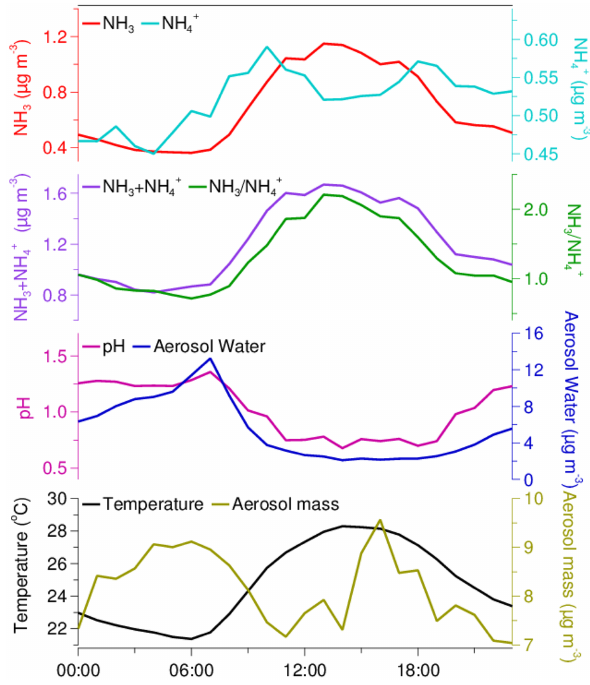
Figure 8. Amines, NH 3 and CH 3 CN concentrations measured on 4 June 2014 in the Alabama forest. The measured ambient temper- Figure 7. The average diurnal variation of the gas phase NH 3 (red), ature is also shown. There was a local trash burning event starting aerosol-phase ammonium (NH + , cyan) measured with ion chro- 4 around 10a.m. The blank period of amines and NH 3 in the after- matography (IC), the sum of NH 3 and NH + (purple), the ratio noon was due to a power outage in the trailer where the CIMS was 4 of NH 3 to NH + (green), ISORROPIA-predicted aerosol pH (ma- 4 genta), ISORROPIA-predicted aerosol water content (blue), ambi- ent temperature (black), and aerosol mass (yellow) for the entire SOAS campaign period. The unit of gas-phase NH 3 concentrations was converted from ppbv to µgm − 3 (1ppbv = 1.3µ g m − 3 ) to be compared with aerosol-phase NH + . 4